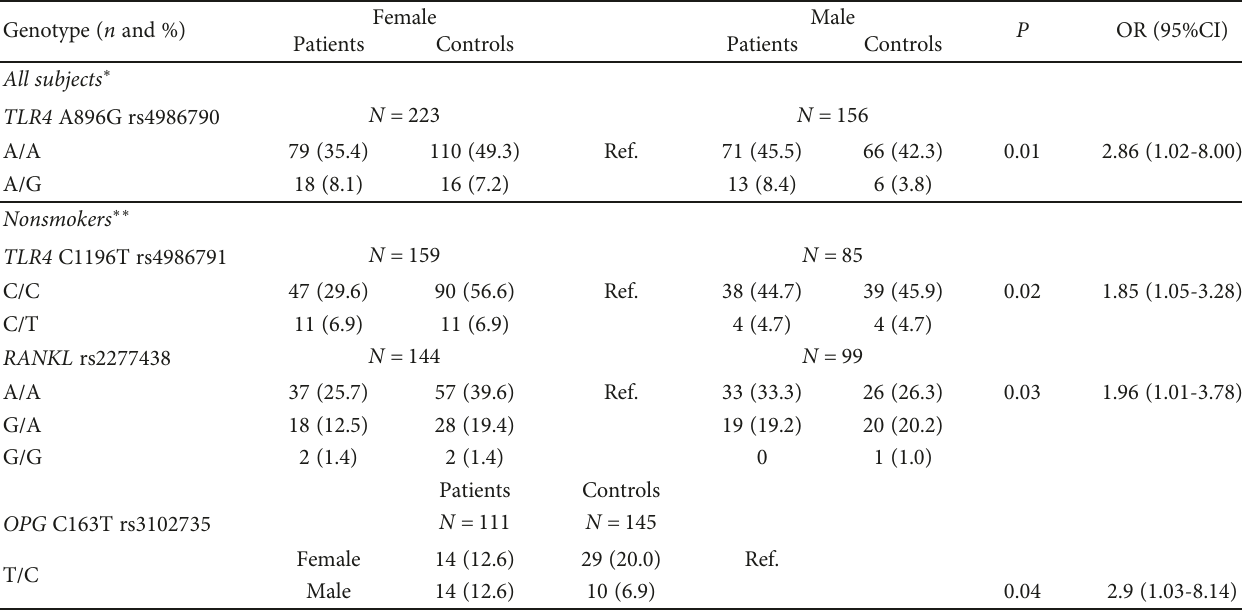
Table 3: TLR4 , RANKL , and OPG genotype frequency distributions between patients with periodontitis and control after strati fi cation according to